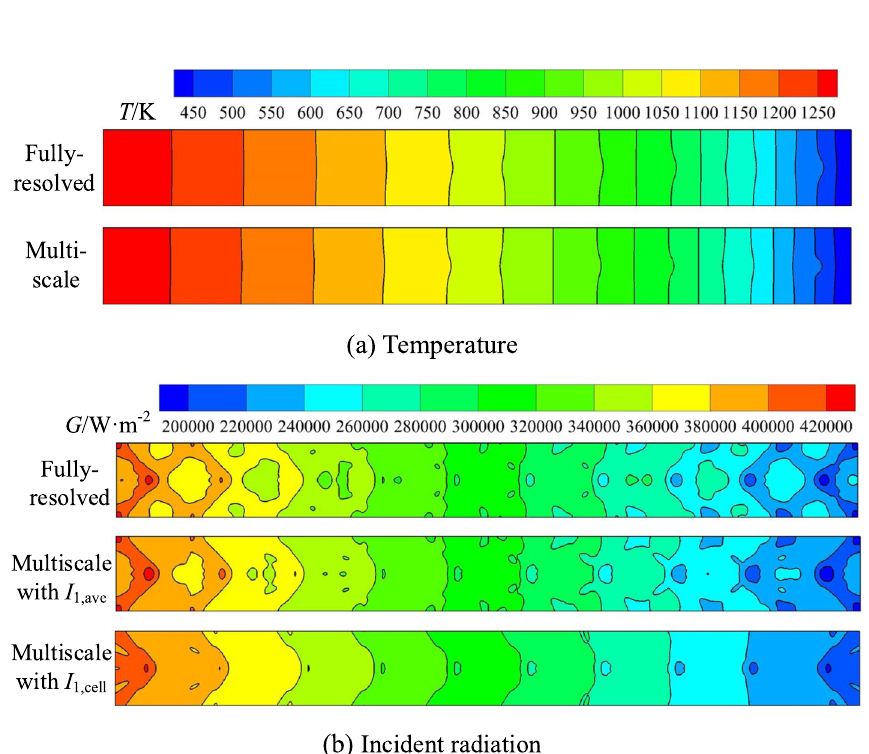
Fig. 5 The temperature and incident radiation fields of the fully‑resolved simulation and the multiscale